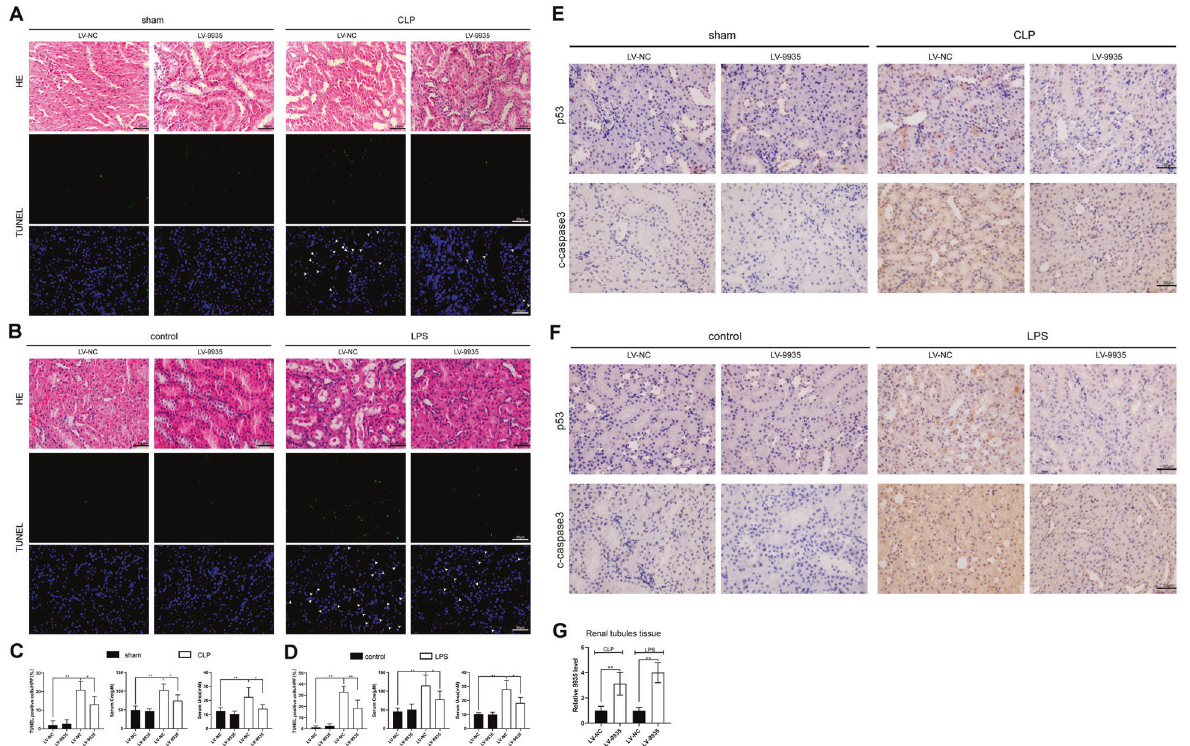
Fig. 3 Effect of lncRNA 9935 on sepsis-induced kidney injury in vivo. The rat model of septic AKI was constructed by a CLP procedure or LPS injection. Two weeks before the modeling, lentivirus (LV)-9935 or its negative control (LV-NC) was injected into rats via the tail vein. n = 6 in each group. A , B Representative images of hematoxylin-eosin (H&E) staining and TUNEL staining performed on kidney sections of rats. C , D The quantitation of TUNEL staining was expressed as the mean number of TUNEL-positive cells in ten high-power fi elds (HPF). The serum levels of creatinine (Cre) and urea were measured by assay kits. E , F Representative images of immunohistochemical staining for p53 and c- caspase 3 performed on kidney sections of rats. G qRT-PCR analysis of the 9935 expression level in the renal tubules of rats. * P < 0.05, ** P <